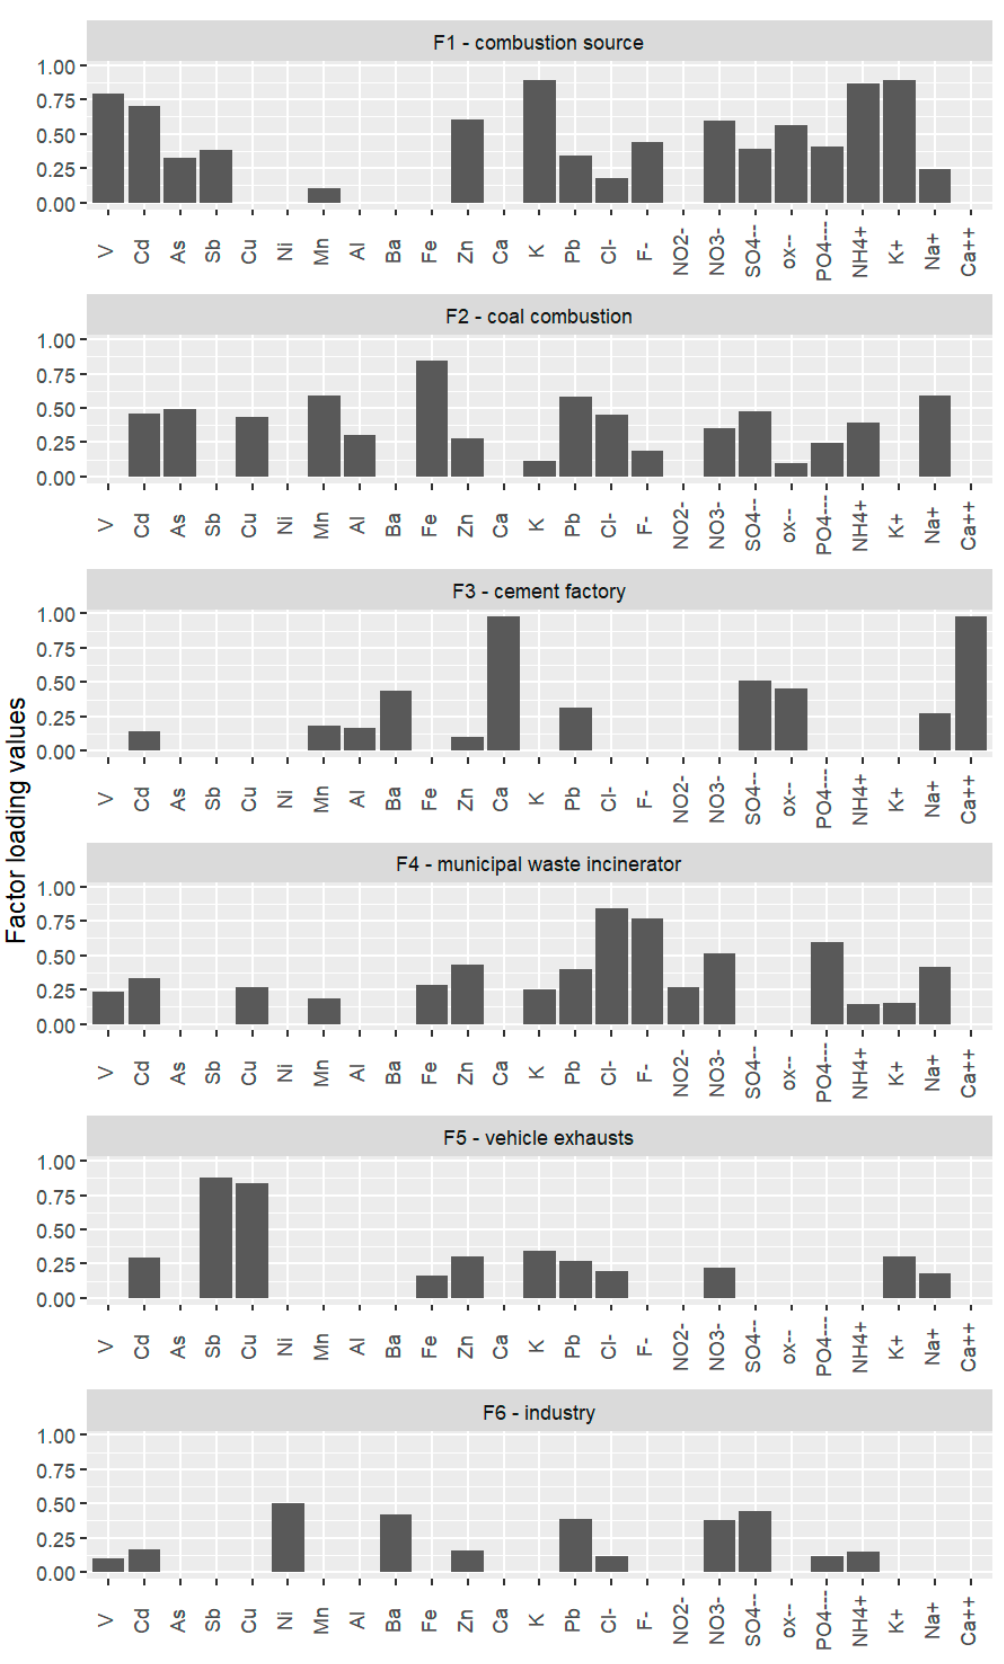
Figure 6. Source profiles for PM 1 in Šlapanice.